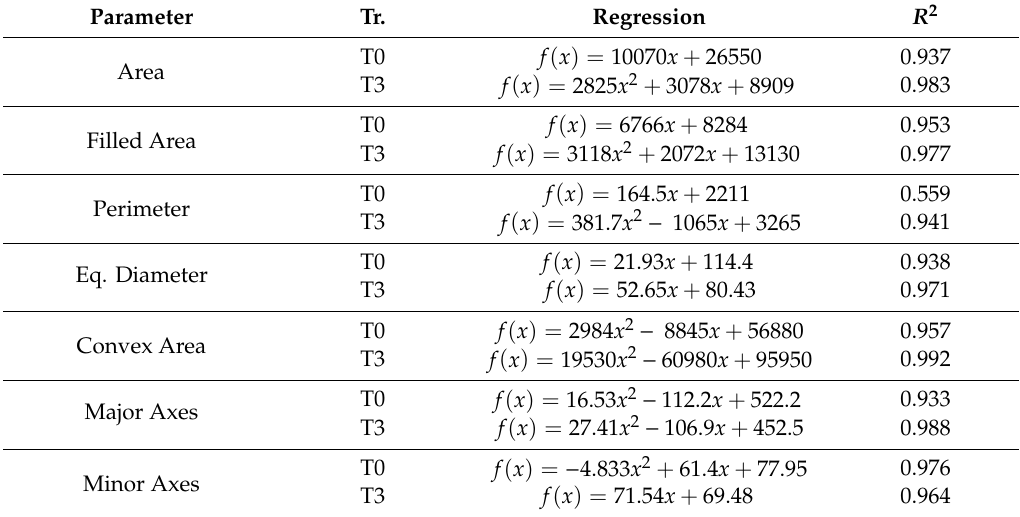
Table 5. Linear and polynomial regressions correlating morphological parameters were acquired using multispectral images to weeks after transplant in different organic fertilization levels in tomato plants at early stages.